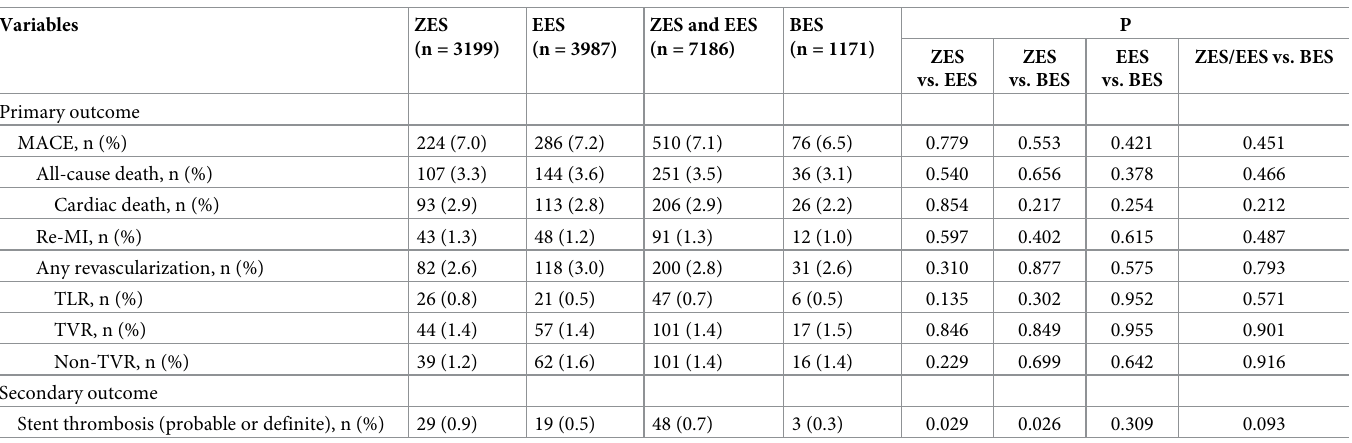
Table 2. Cumulative clinical events at 2 years before